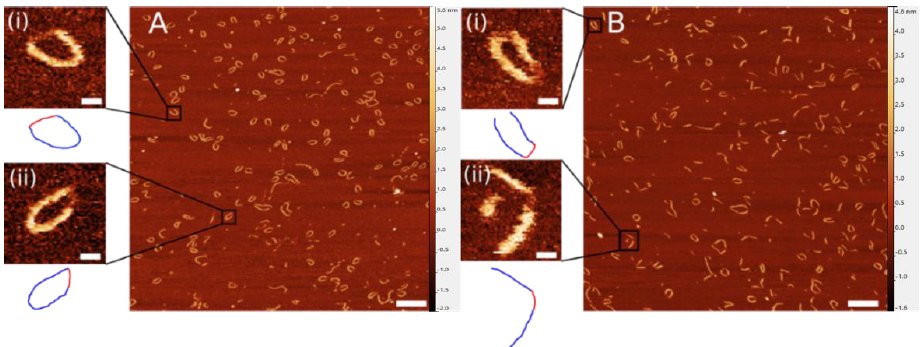
Figure 3. Representative images of nanoring complexes ( A ) and gap constructs ( B ) with zoomed-in examples ( i , ii ) imaged in liquid. Cartoons below images depict measurements of double-stranded DNA (blue) and single-stranded DNA (red). Scale bars indicate 100 nm in large-scale images and 10 nm in zoomed-in images.